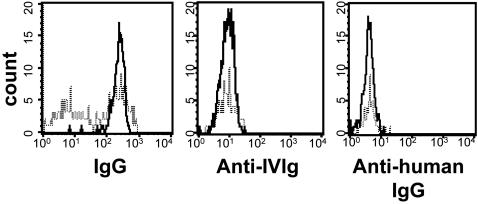
IVIg-mobilized plasma cells are neither IVIg- nor human IgG-specific.CD19+CD27high plasma cells were analyzed following intracellular staining with anti-IgG FITC, IVIg FITC and human IgG FITC before (dotted line) and 7 days after IVIg infusion (black line). One representative individual out of 17 analyzed.